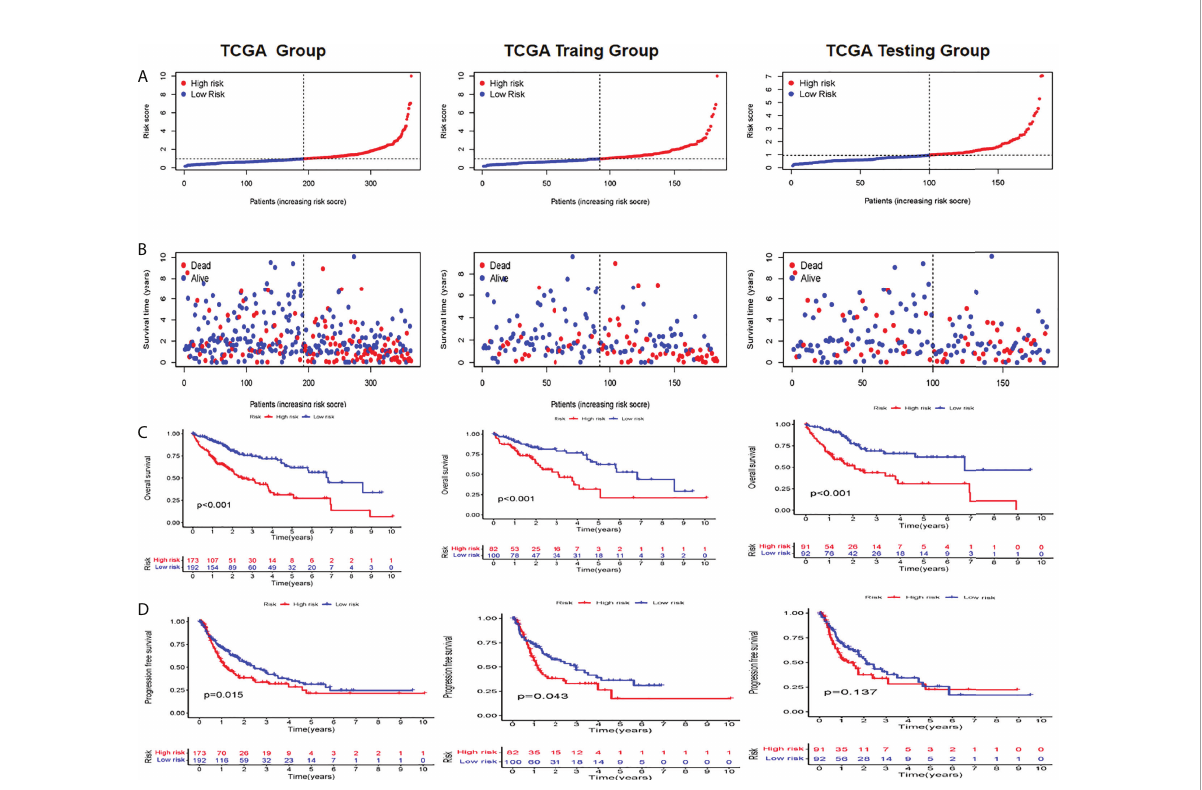
FIGURE 2 Evaluation and validation of the utility of CRLs in TCGA, training, and testing sets (A) Distribution of the patients normalized CRL scores (B) Patients ’ overall survival (OS) time along with their CRL score (C) K M analyses of OS between high- and low-CRL groups (D) K-M analyses of PFS between high- and low CRI. groups in the training set. C1 cuproptosis index, CRL suproptons related lncRNAs, K M Kaplan-Meier, OS overall survival PFS, progression-free